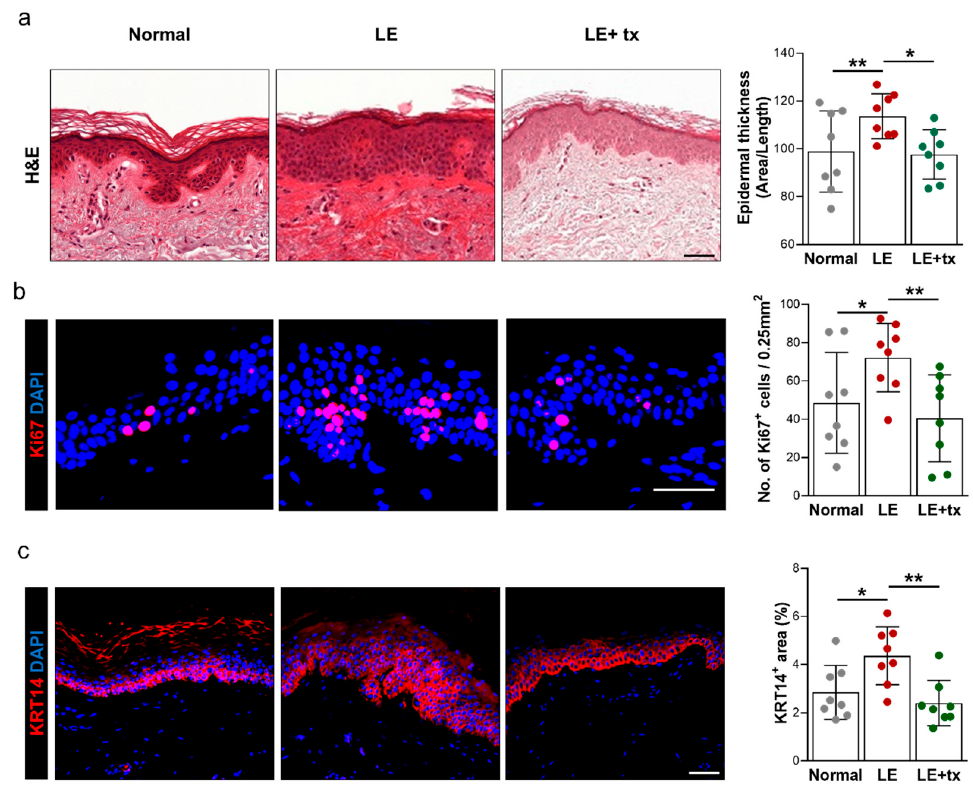
Figure 3. Treatment with QBX258 decreases hyperkeratosis and keratinocyte proliferation in lymphedematous skin. ( a ) Representative H&E images (right panels) and quantification (right panel; average ± SD) of matched normal, lymphedematous skin before treatment (LE), and lymphedematous skin biopsy specimens obtained 4 months after treatment with QBX258 (LE + tx). ( b ) Representative immunofluorescent staining of normal, LE, LE + tx biopsy specimens stained for DAPI (nuclear stain, blue) and Ki67 (nuclear stain, pink). ( c ) Representative immunofluorescent staining of normal, LE, LE + tx biopsy specimens stained for DAPI (nuclear stain, blue) and KRT14 (membrane stain, pink). Scale bars: 50 μ m; * p < 0.05; ** p < 0.01.